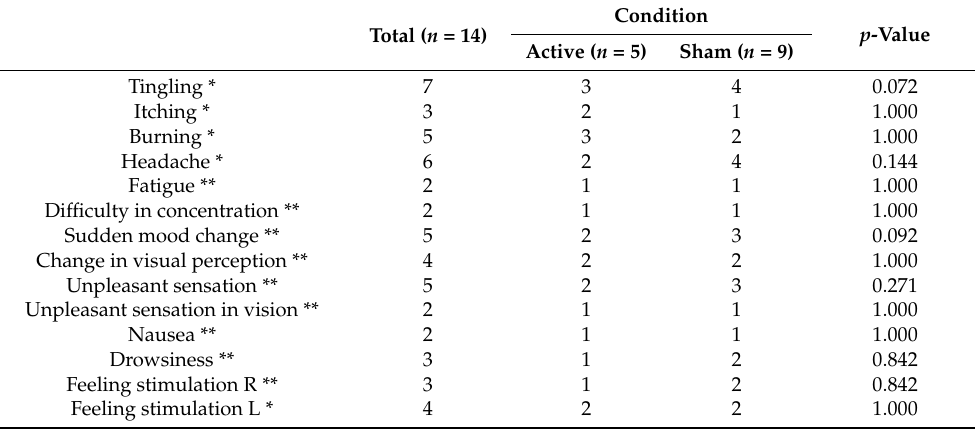
Table 5. Number of occurrences of side effects between active and sham groups for the PPC (posterior parietal cortex).